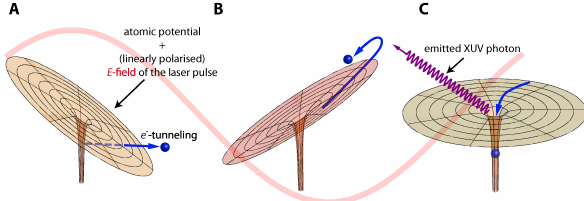
Figure 4: Three-step model of HHG. a , Ionization of an atom by a strong electromagnetic field, resulting in a free electron. b , Sub- sequent acceleration of the free electron in the field, reversal of direction after half an optical period. c , Return of the electron to the original ion, recombination under emission of a high energetic pho- ton. All steps are described in more detail in the respective sections